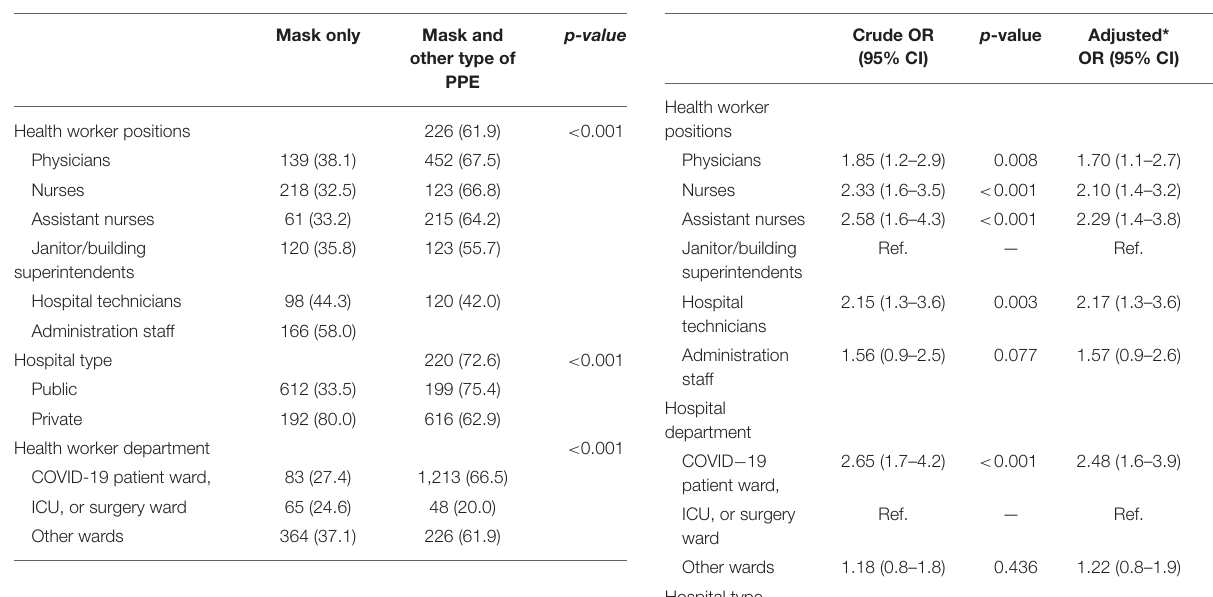
TABLE 2 | PPE usage among HCWs and hospitals. TABLE 4 | Crude and adjusted odd ratios for the outcome of seropositive